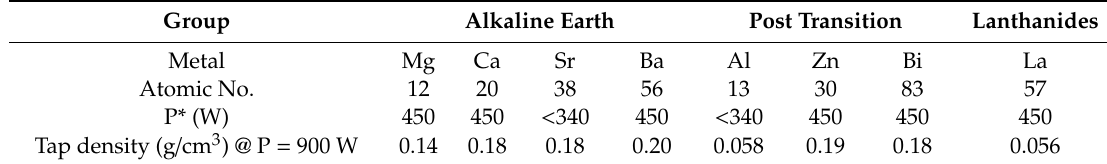
Table 2. Critical power (P*) for selected catalyst promoters when M / Si = 1 / 3.